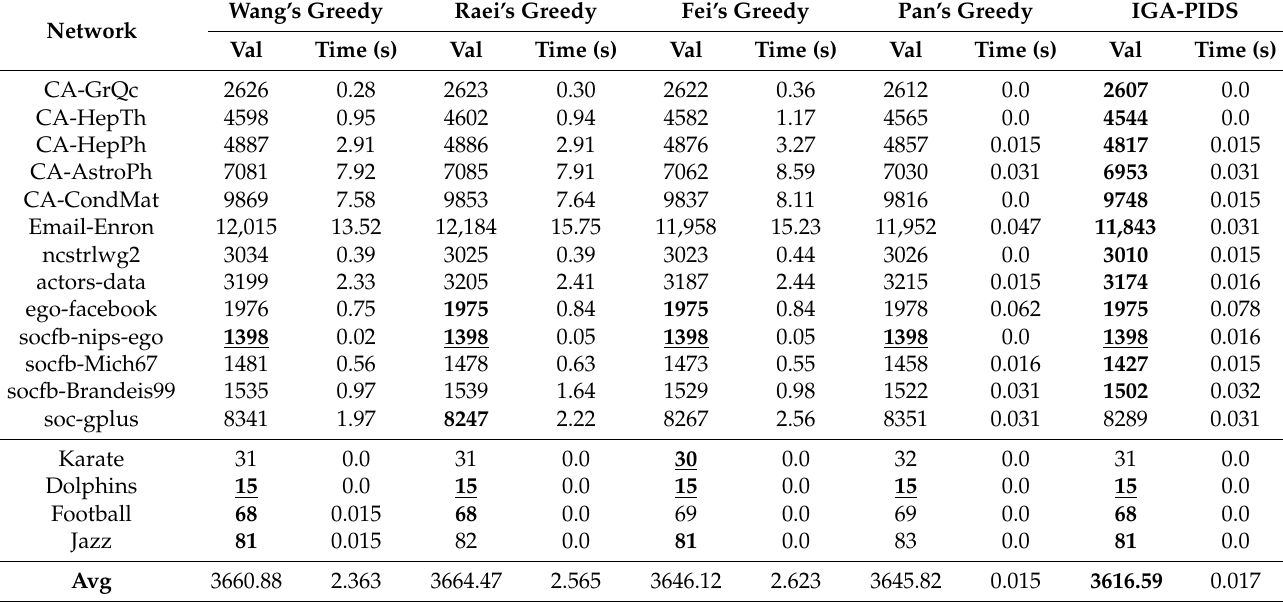
Table 5. Numerical results for the small and large-scale real social networks. .